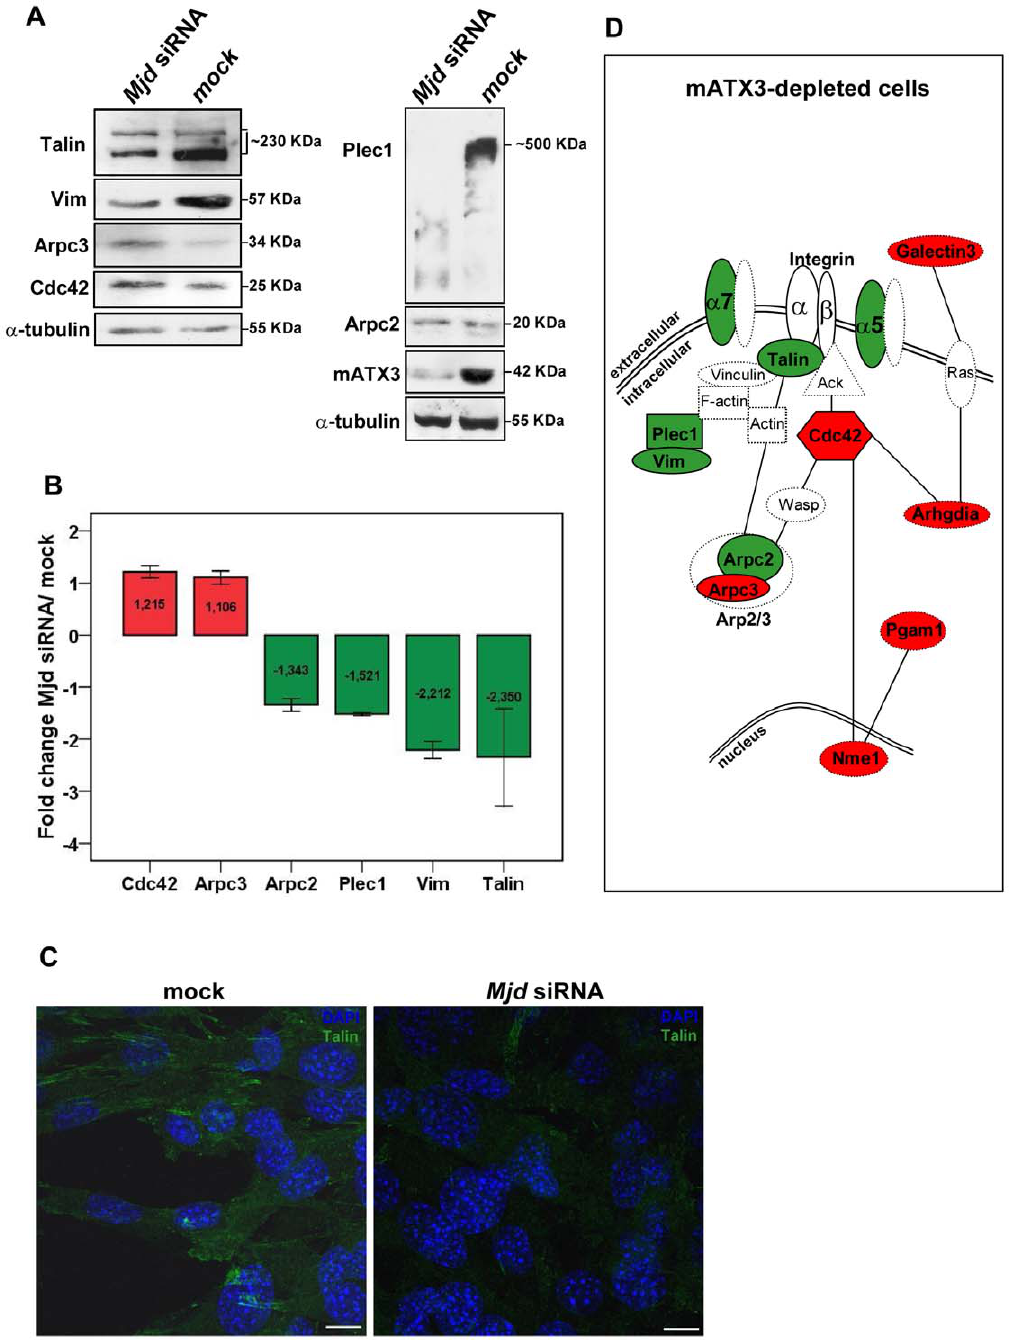
Figure 7. Ataxin-3 depletion affects the levels of proteins involved in the integrin signaling cascade which regulates cytoskeleton organization, cell adhesion and motility. (A) The levels of Cdc42, Arpc2, Arpc3, Plec1 and Vim, were found to be altered in a proteomic analysis of mATX3-depleted C2C12 cells (Day 0). These results were confirmed by immunoblotting of whole cell extracts of undifferentiated (Day 0) mock and Mjd siRNA transfected cells. The levels of Talin were also found to be downregulated by immunoblotting analysis. (B) Fold change correspondent of relative band density of each protein in Mjd siRNA transfected cells comparing with control cells. The results were normalized for a -tubulin and correspond to the average of three independent transfections 6 SEM (error bars). (C) Maximum projections of confocal optical z-series images of immunofluorescence staining for Talin (green) of undifferentiated mock or Mjd siRNA-transfected C2C12 cells (Day 0). DNA was stained with DAPI (blue). Scale bars represent 10 m m. (D) Scheme of the proteins showing altered levels upon mATX3-depletion in C2C12 cells and related with the integrin signaling pathway (based in the analysis performed with the Ingenuity Pathway Analysis H software). Upregulated and downregulated proteins found in the proteomic analysis, as well as a 5 and a 7 integrin subunits, are shown in red and green, respectively. Proteins with confirmed altered levels by further immunoblotting and/or immunofluorescence are represented by full-surrounded lines, and the ones only identified as altered in the proteomic analysis by dashed-surrounded lines.